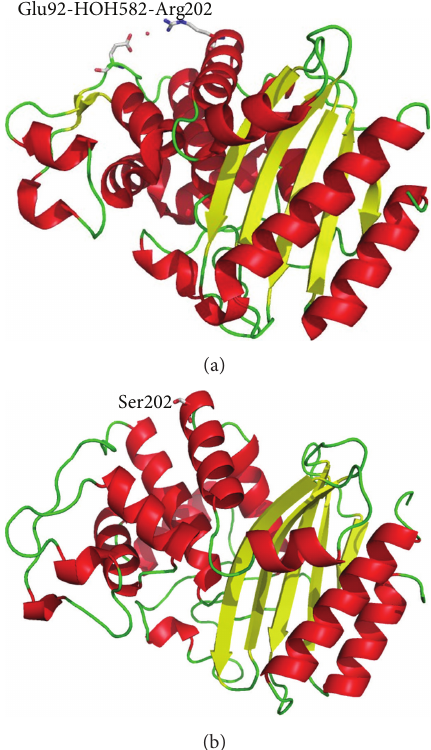
Figure 1: Tertiary structure of (a) SHV-1 and (b) SHV-104. The 𝛽 - strands are shown in yellow and the helices 𝛼 in